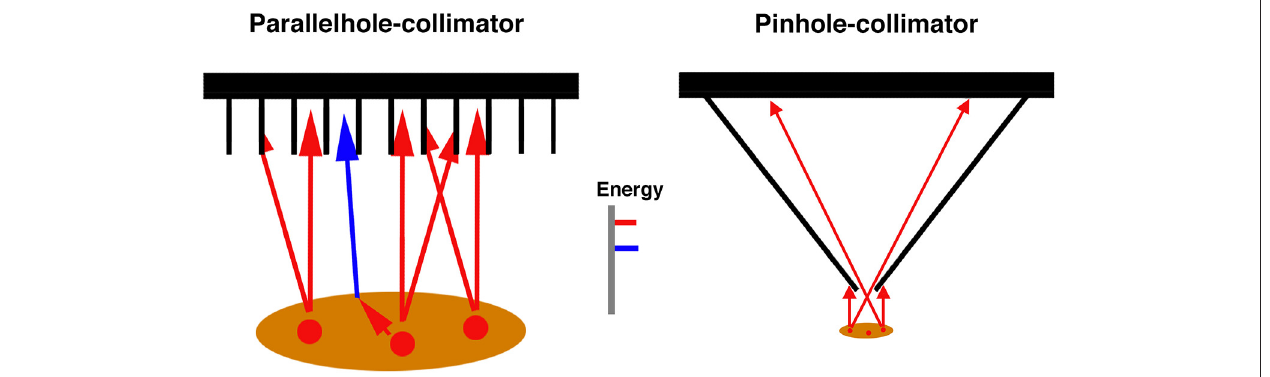
FIGURE 2 | Two collimator types used in SPECT imaging. Parallel-hole collimators, frequently used in SPECT imaging in humans, absorb photons that would reach the detector—within limits—at oblique angles after emission from the sources. The sources are depicted in red. Scattered photons (blue, shown only for the parallel-hole collimator) can be distinguished from non-scattered photons due to their lower energy. When pinhole collimators are used, magnified 2D projection images form on the detector if the imaged objects are close to the